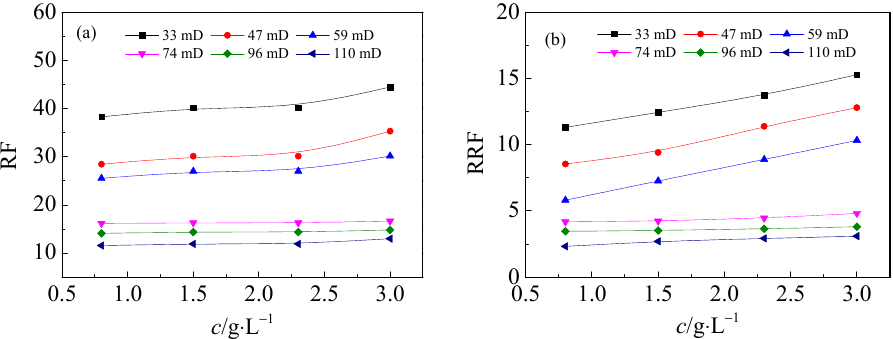
Figure 10. Dependence of ( a ) the resistance factor (RF) and ( b ) the residual resistance factor (RRF) for HW-HPAM/ANS solution on the HW-HPAM concentration in different permeability cores. c ANS = 3.0 g ⋅ L − 1 .